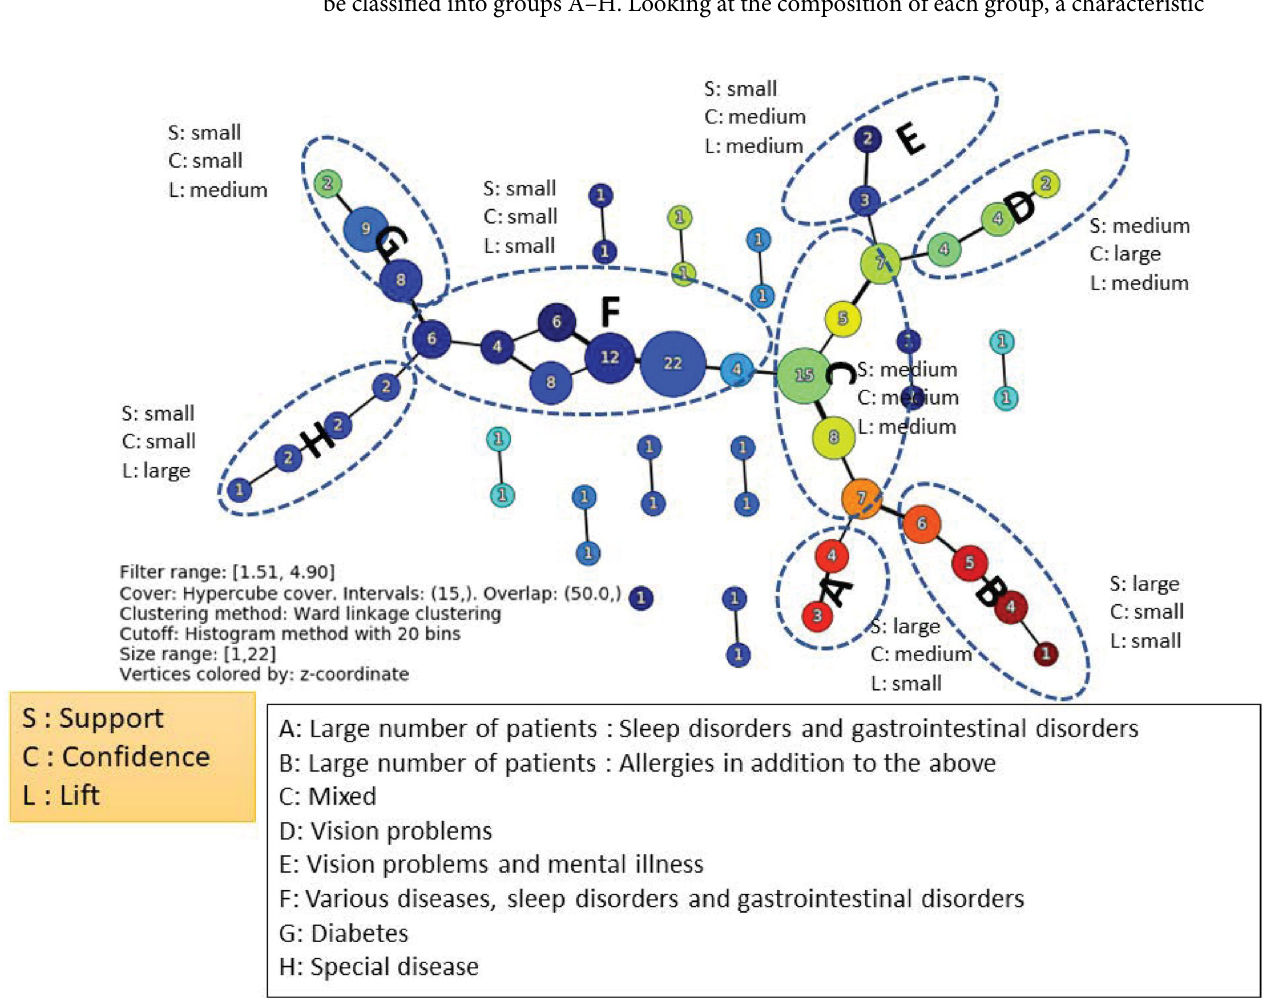
Fig 3. TDA mapper for the association rules of medical histories before the onset of